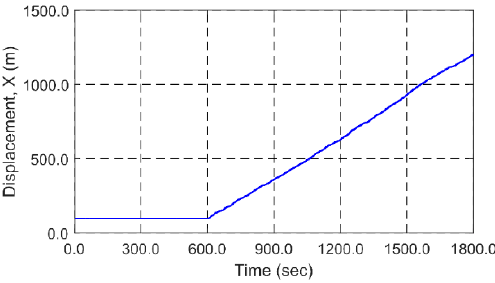
Figure 18. Time histories of the surge motion of the location buoy in the middle location as the rope in the middle location (Y = 0 m) is broken after 600 s ( H s = 2.0 m, T p = 7.0 s, current velocity = 0.6 m/s).